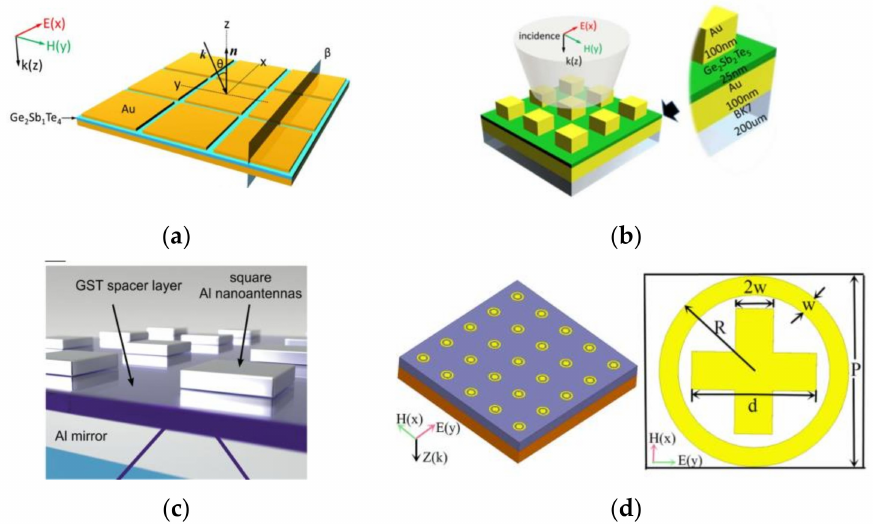
Figure 3. The PCM hybrid metal-insulator-metal (MIM) tunable absorbers by different meta-atoms or PCMs. Au squares on top of ( a ) G 2 S 1 T 4 and ( b ) G 2 S 2 T 5 spacer with metal ground underneath; ( c ) Al antennas on top of G 3 S 2 T 6 spacer layer for mid-IR MIM tunable absorber; ( d ) a THz tunable absorber for the metaswitch using composite meta-atoms—( a – d ) are reproduced with permission from references [130] (@The Optical Society), [27,129,131]